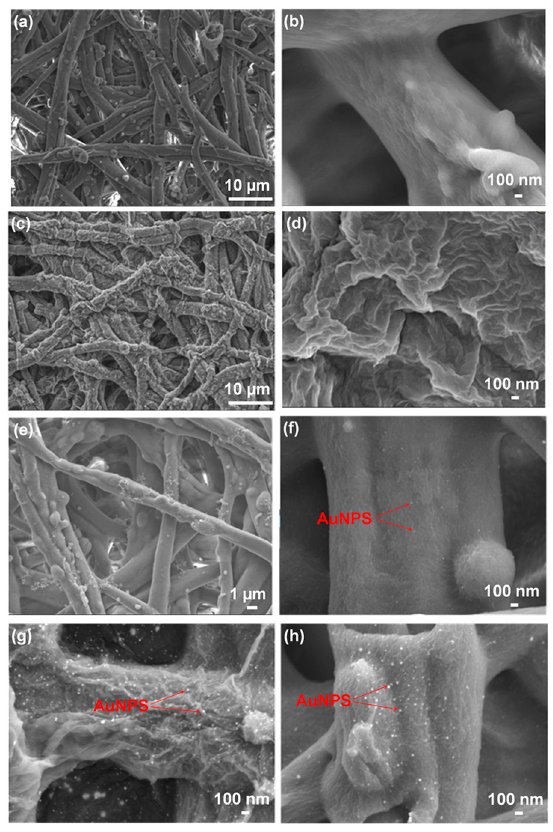
Figure 3. SEM images of different ESM samples: ( a , b ) pristine ESM, ( c , d ) GO/ESM, ( e , f ) AuNP/ESM, ( g ) AuNP/GO/ESM, and ( h ) GO/AuNP/ESM.